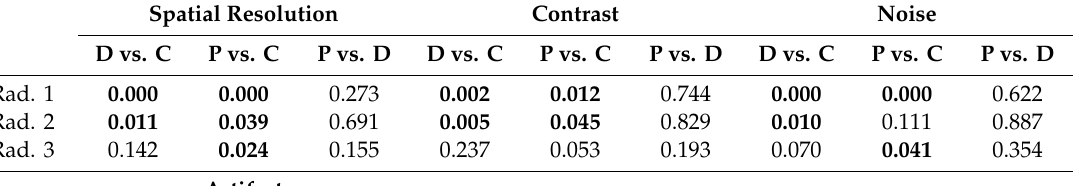
Figure 6. Mean score di ff erences of in vivo images ( N = 52) between DWI and CF ( d D vs. C ), PWI and CF ( d P vs. C ), and PWI and DWI ( d P vs. D ). The asterisk indicates a significant di ff erence ( p < 0.05). DWI and PWI show higher scores than CF in all cases, with significant di ff erences in some cases. PWI and DWI show a similar performance with no significant di ff erences. Table 3. P-values of the rank-sum test between each pair of CF, DWI, and PWI in the in vivo image evaluation ( N = 52) (all P-values less than 0.05 (i.e., statistically significant di ff erences) are shown in bold).